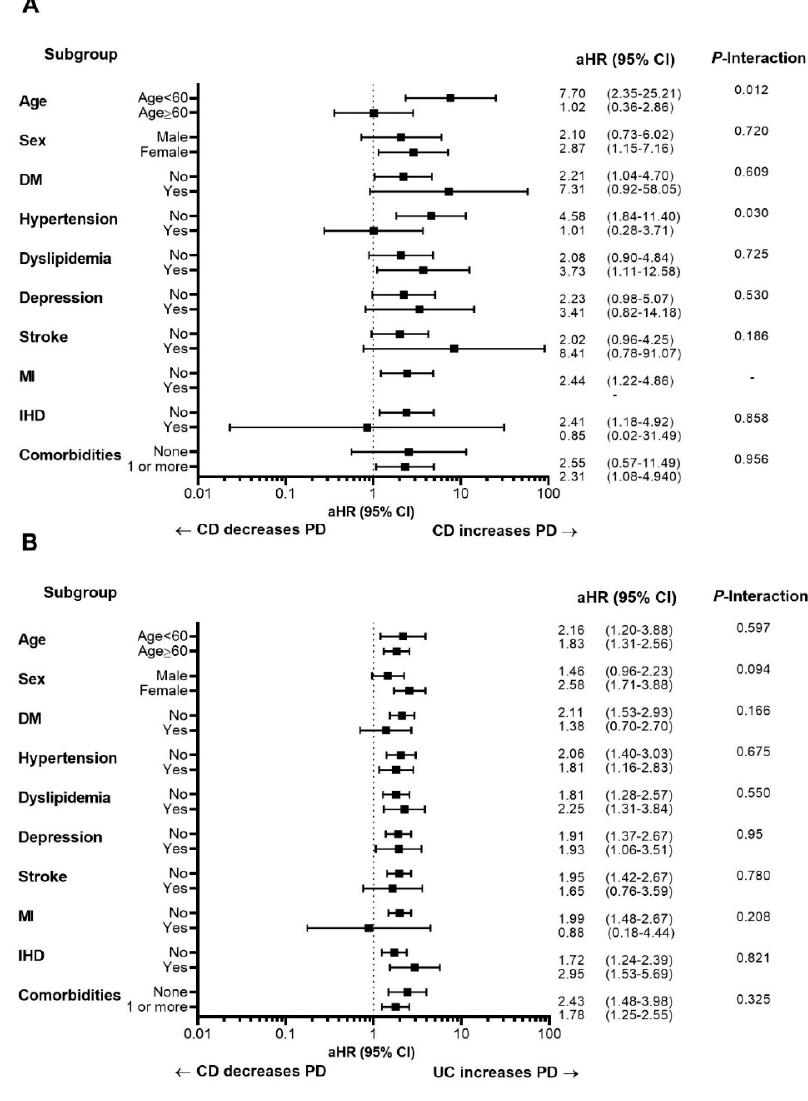
Figure 2. Analysis of Parkinson’s disease in subgroups of patients with inflammatory bowel disease. The cohort was divided into patients with ( A ) Crohn’s disease or ( B ) ulcerative colitis. Subgroups included younger / older age, male / female sex, patients with / without DM, hypertension, dyslipidemia, depression, stroke, myocardial infarction, ischemic heart disease, and patients with / without comorbidities. Abbreviations: CD, Crohn’s disease; CI, confidence interval; DM, diabetes mellitus; aHR, adjusted hazard ratio; IHD, ischemic heart disease; MI, myocardial infarction; PD, Parkinson’s disease; UC, ulcerative colitis.